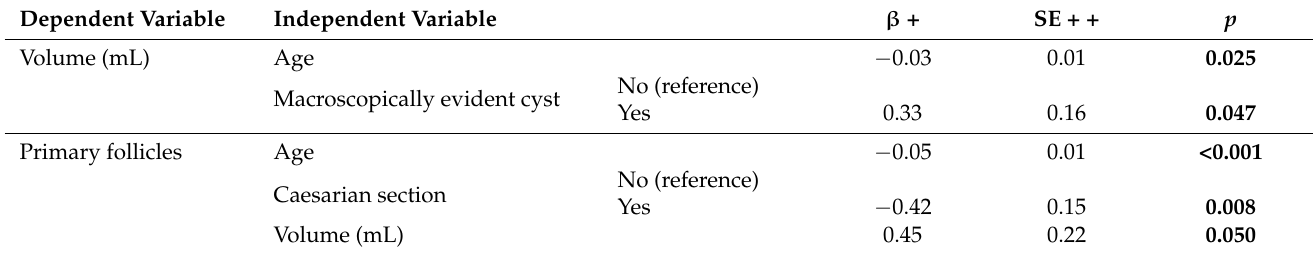
Table 5. Multivariate linear regression results with volume and number of primordial/primary follicles, in a stepwise